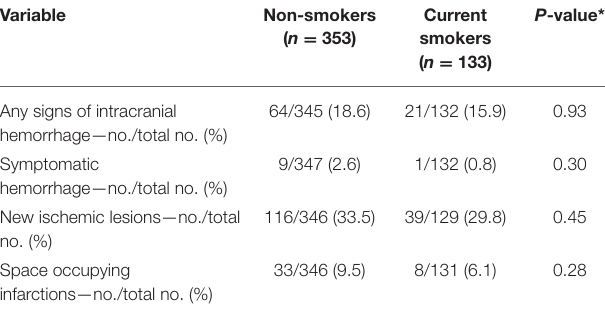
TABLE 2 | Safety outcomes according to smoking